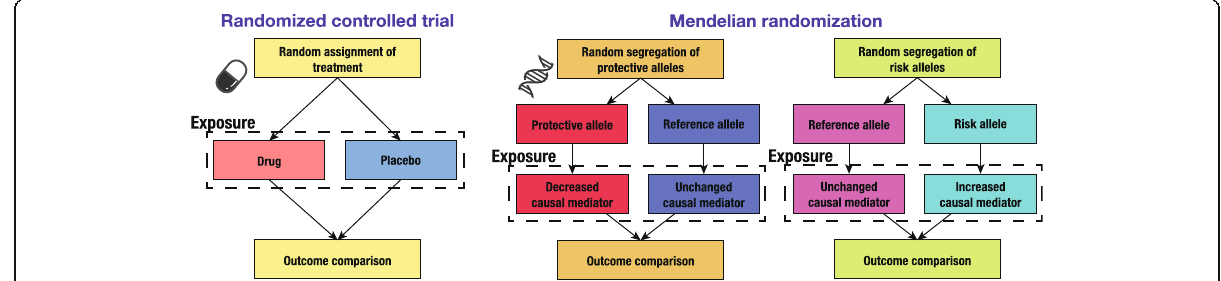
Fig. 1 Schematic comparison between the randomized controlled trial and Mendelian randomization. Two schematic diagrams are shown for Mendelian randomization separately for the effect direction of the non-reference allele, i.e. protective or causal (risk allele). For simplicity, a single genomic locus is depicted in the diagrams of Mendelian randomization. Note that multiple loci are considered for statistical evaluation in practical settings. In RCT, random assignment of a treatment minimizes the effects of confounders. In MR, random segregation of alleles during gamete formation plays a similar